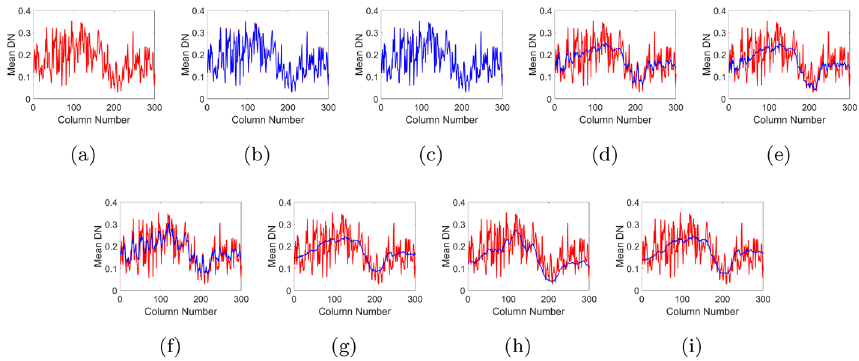
Fig. 8 Vertical mean profiles of band 155 in the GF-5 Shanghai image before and after denoising via the different methods: a Original image; b BM4D; c LRMR; d NAILRMA; e LLRGTV; f MTGSNMF; g SSTVSSLR; h HSI-SDeCNN; i SRGLR (proposed). The red and blue curves represent the mean DN of the original and restored images, respectively